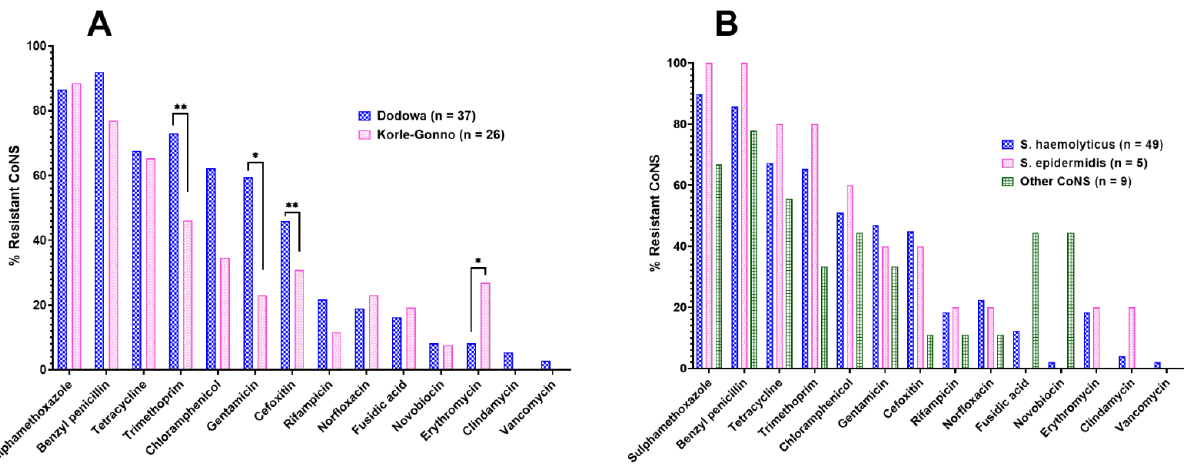
Figure 2. Resistance of isolated CoNS species to test antibiotics. ( A ) Distribution of resistance of isolates from the two communities. ( B ) Breakdown of resistance of the different CoNS species to the test antibiotics. Statistical analysis by two-way ANOVA with Sidak’s post-test showed significant differences in some of the proportions of resistant CoNS against some antibiotics from the two communities: * p < 0.05 & ** p < 0.01.